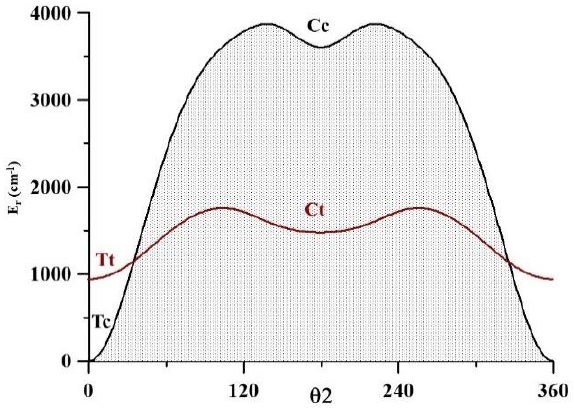
Figure 5. The CCSD(T)-F12 V CC torsional barriers. The Tc → Cc and Tt → Ct pathways were computed using the θ 1 and α values of the Tc and Tt conformers, respectively.